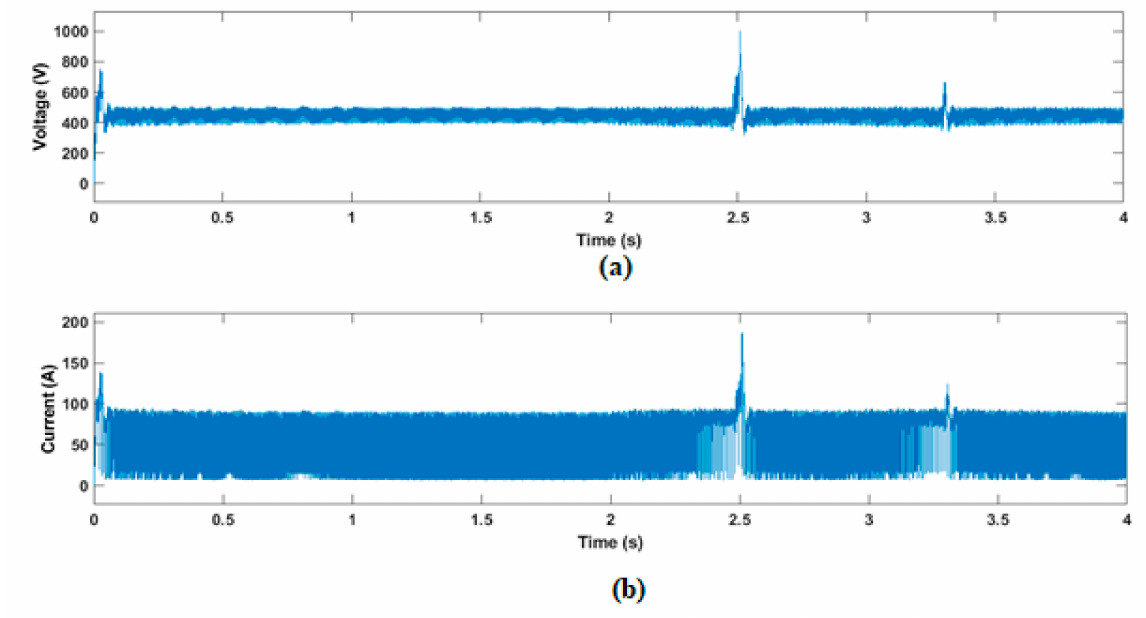
Figure 25. Boost converter outputs ( a ) voltage and ( b ) current during